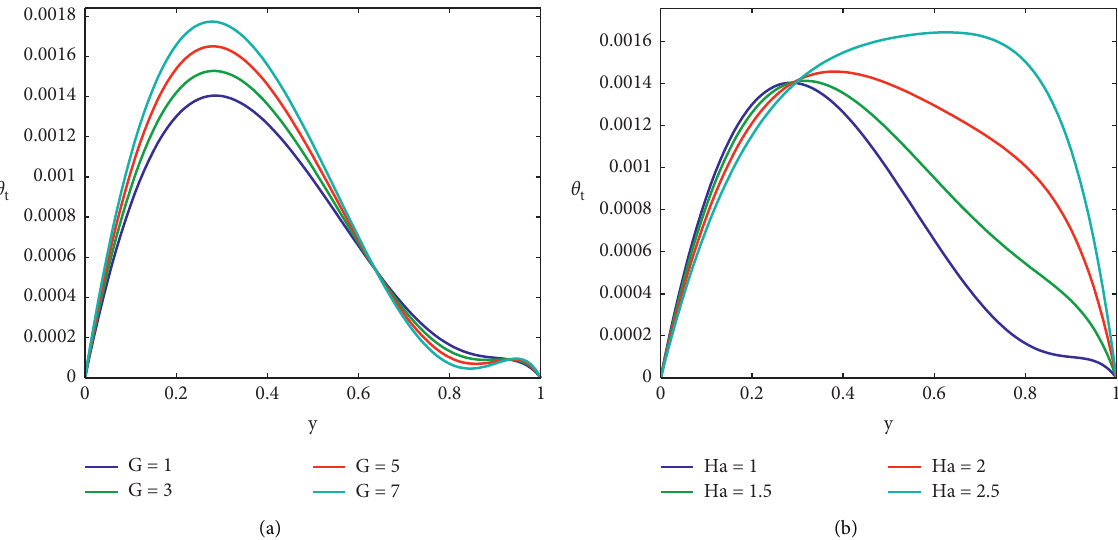
Figure 9: (a) Effect of G on unsteady “temperature distribution” when Ha � 1. (b) Effect of Ha on “unsteady temperature distribution” for G �